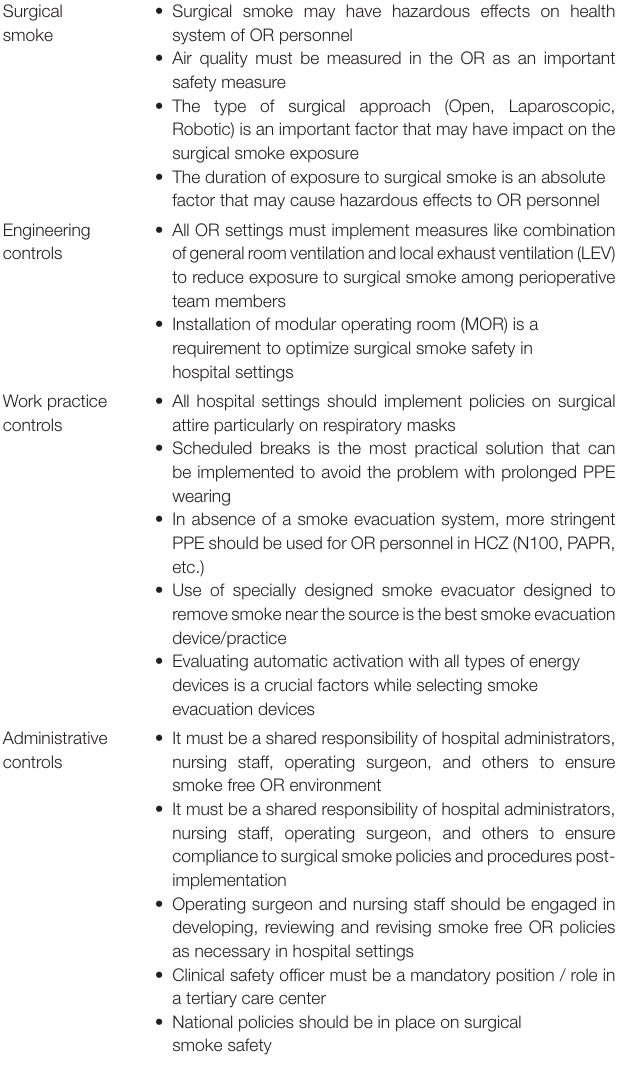
TABLE 1 | Key statements achieving